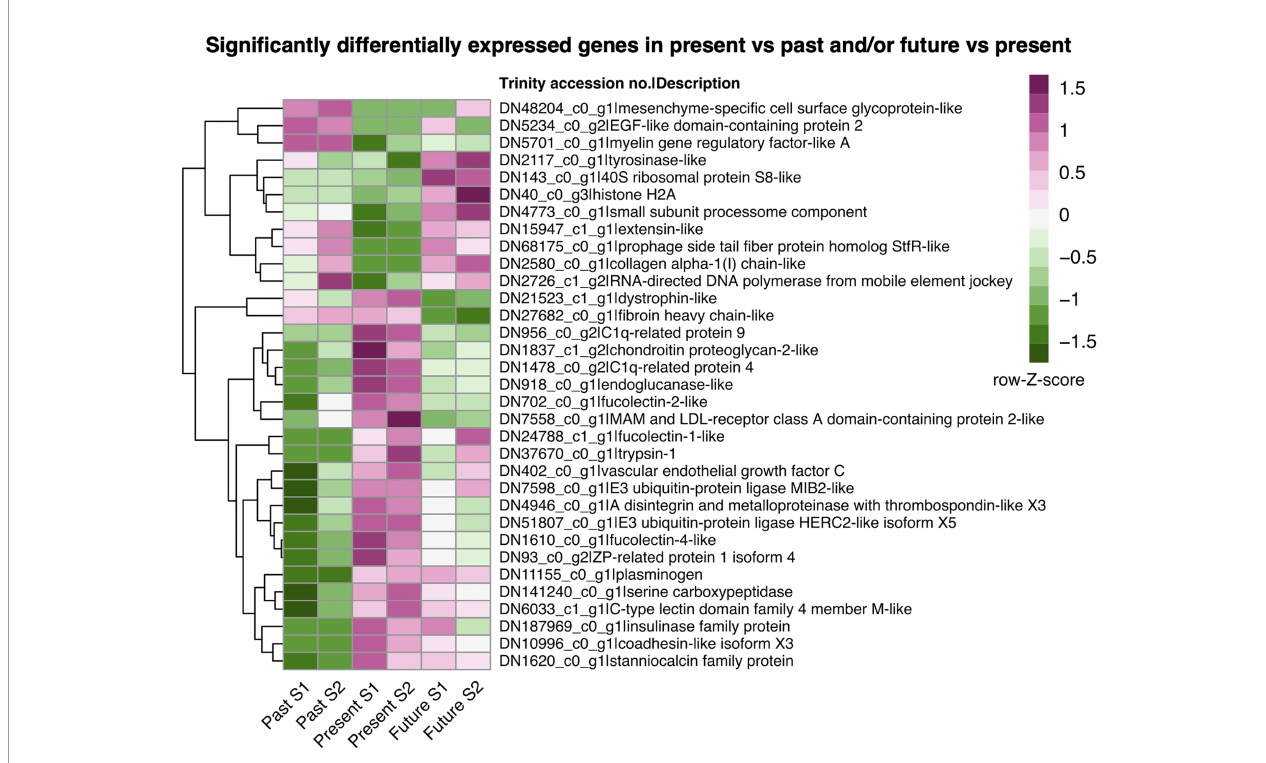
FIGURE 2 | Heatmap illustrating the expression patterns of the statistically signi fi cant differentially expressed genes (DEGs) in adult Atlanta ariejansseni from past (mid-1960s), present (ambient) and future (2050) ocean chemistry conditions. Gene loci as predicted by Trinity are labelled by their accession numbers in the assembly followed by the description of the blast best hit. Visualization is based on the row Z-scores of the log count per million of the genes. The statistically signi fi cant DEGs were determined with DESeq2 using the negative binomial distribution. Pairwise comparisons were done in the direction of the decreasing pH and included the contrasts future versus present and present versus past using an alpha of 0.05. Multiple testing correction was performed using the Benjamini- Hochberg method (p-adj <